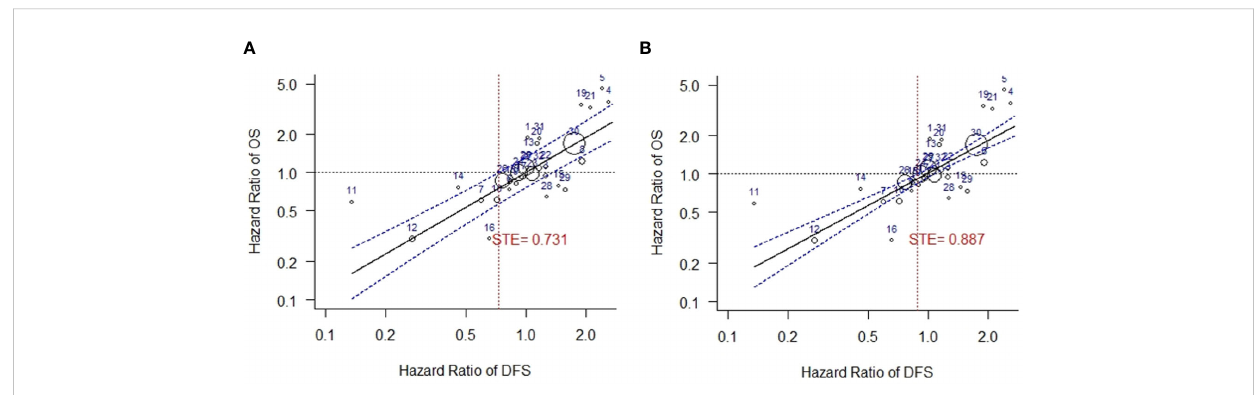
FIGURE 5 Surrogate threshold effect (STE) analysis for DFS vs. OS. (A) STE analysis with variance of HR of DFS as weights. (B) STE analysis with variance of HR of OS as weights. DFS, disease-free survival; OS, overall survival; STE, surrogate threshold effect.